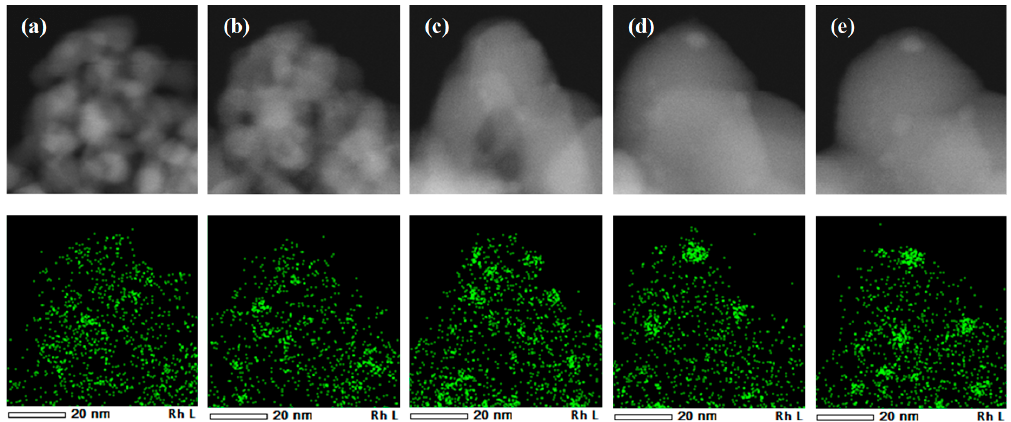
Figure 2. TEM images and EDS mapping of Rh in Rh/ZrO 2 under vacuum conditions at ( a ) 300 °C, ( b ) 900 °C, ( c ) 950 °C, ( d ) 1000 °C, and ( e ) 1050 °C.